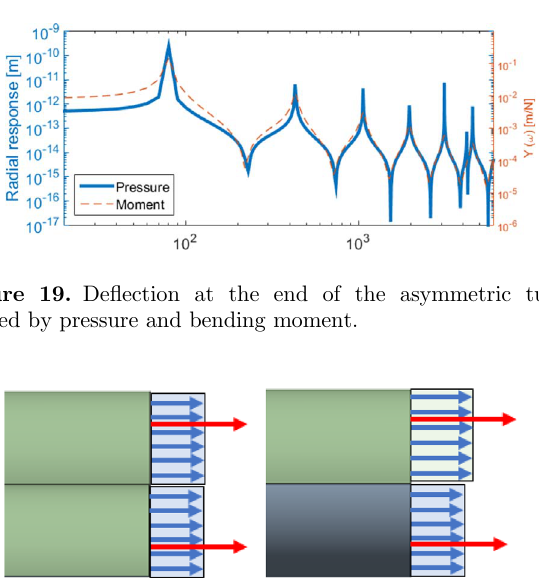
Figure 20. Representation of axial stress generated in sym- metrical and asymmetrical tubes excited by internal pressure.